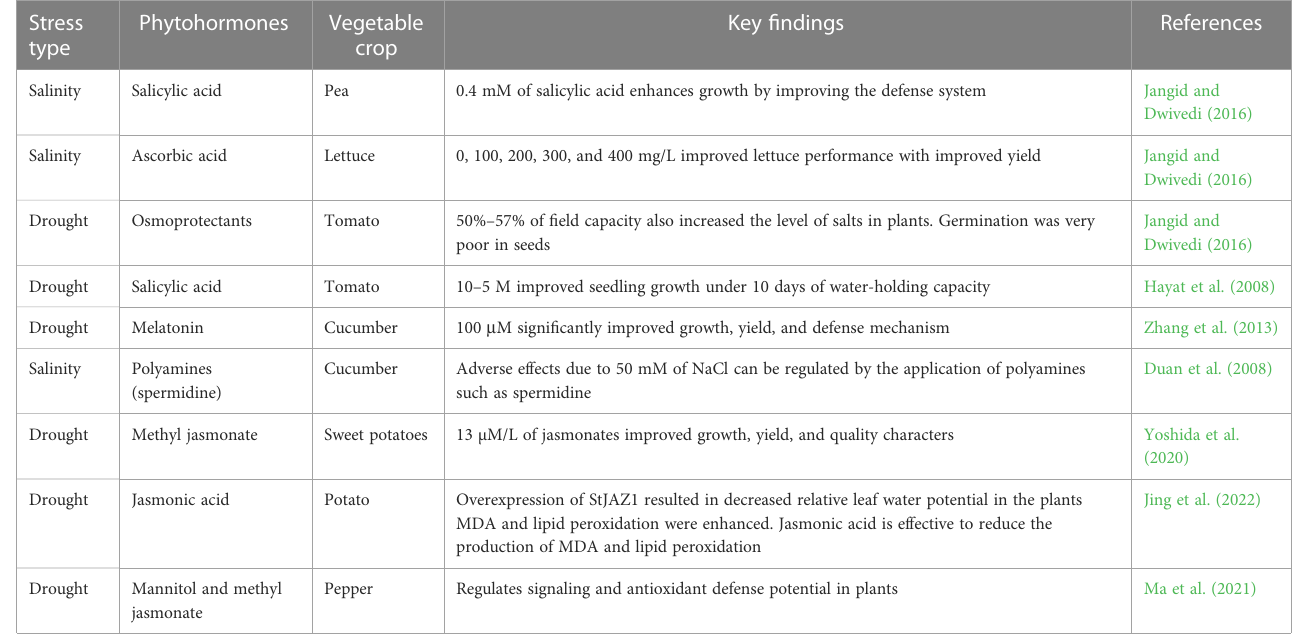
TABLE 2 The role of exogenous phytohormones against drought and salinity stresses in vegetable production. Stress